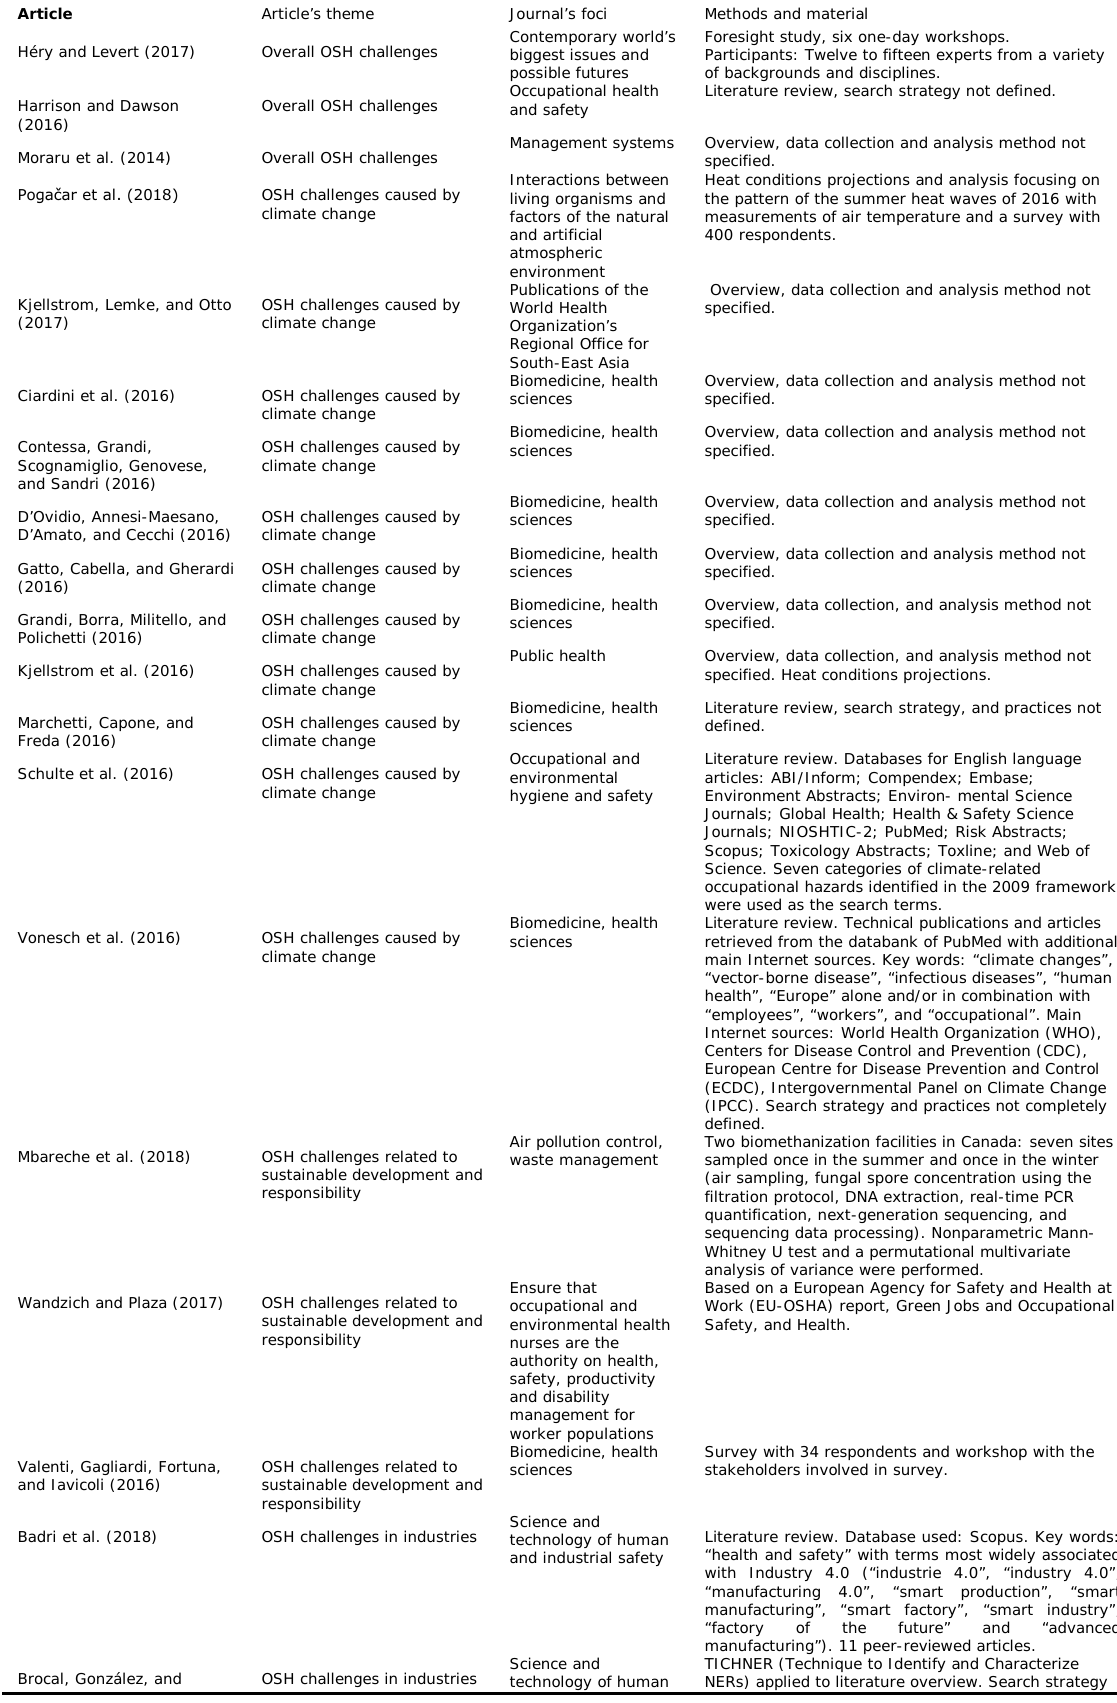
Table A1. Selected articles divided by themes. The order inside the themes is from most recent to oldest